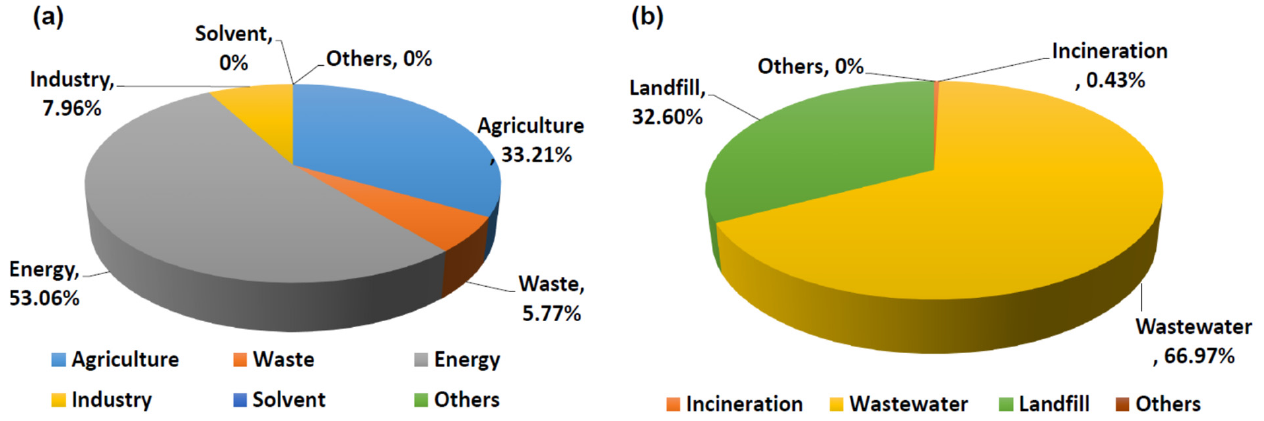
Figure 1. National level GHG emissions in Viet Nam: ( a ) contribution from various emission sectors (in %) and ( b ) contribution of various activities in the waste sector [5].